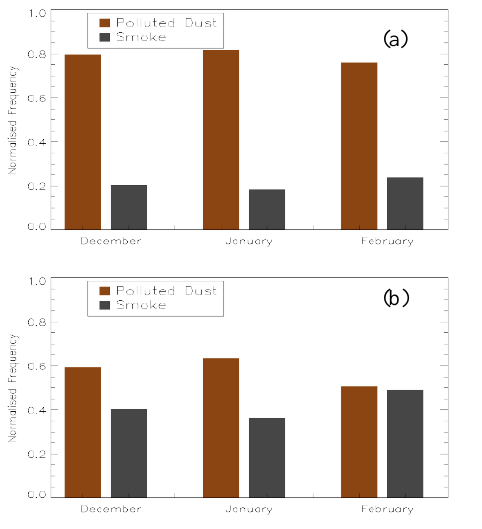
Figure 4 monthly distributions of polluted dust and smoke over (a)NCP and (b)YRD region for winter 2007-2016 In the CALIPSO algorithm scene classification algorithms, optical properties such as volume depolarization ratio and attenuated backscatter color ratio are used in conjunction with spatial information to distinguish aerosol layers from clouds. The particulate color ratio (backscatter at 1064 nm/532 nm) is an indicator of particle size and was calculated on a profile-by- profile basis and later averaged. Figure 5a shows the histogram of the particulate color ratio in eastern China for 2007-2016 winter. The particulate color ratio has a sharp peak near 0.4–0.7 suggesting that smaller particles dominate the size distribution during the winter months. This color ratio distribution is generally consistent with the backscatter color ratios for mixed plumes (polluted dust and smoke) extracted by CALIPSO. The volume depolarization ratio is the ratio of the vertical backscattering coefficient of 532 nm to the parallel backscattering coefficient of 532 nm, reflecting the degree of irregularity of the measured particulate matter. The larger the depolarization ratio is, the more irregular the particles are, and the spherical and non-spherical aerosol particles can be distinguished by the depolarization ratio. Retrieved